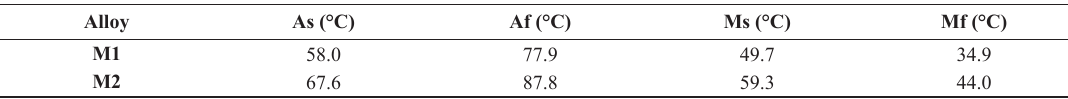
Table 1. Phase transformation temperatures of the row materials a . Alloy